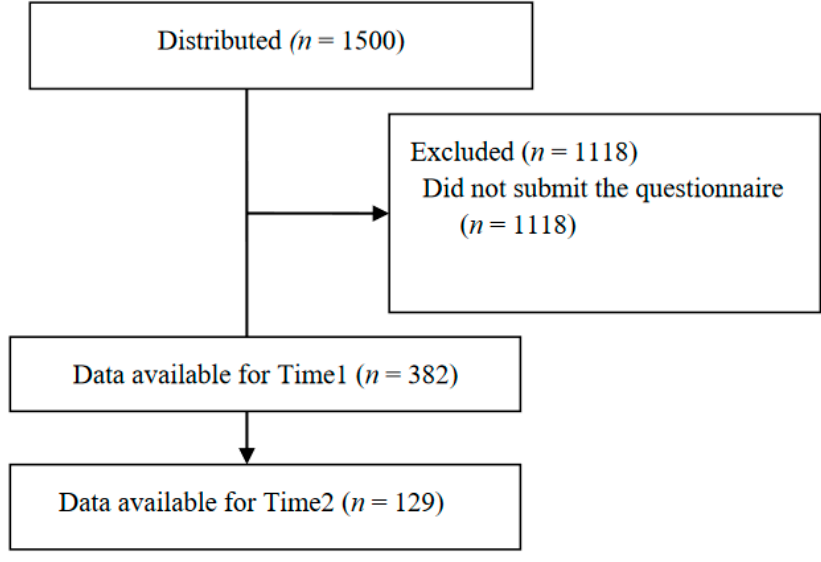
Figure 1. A Study Flowchart.